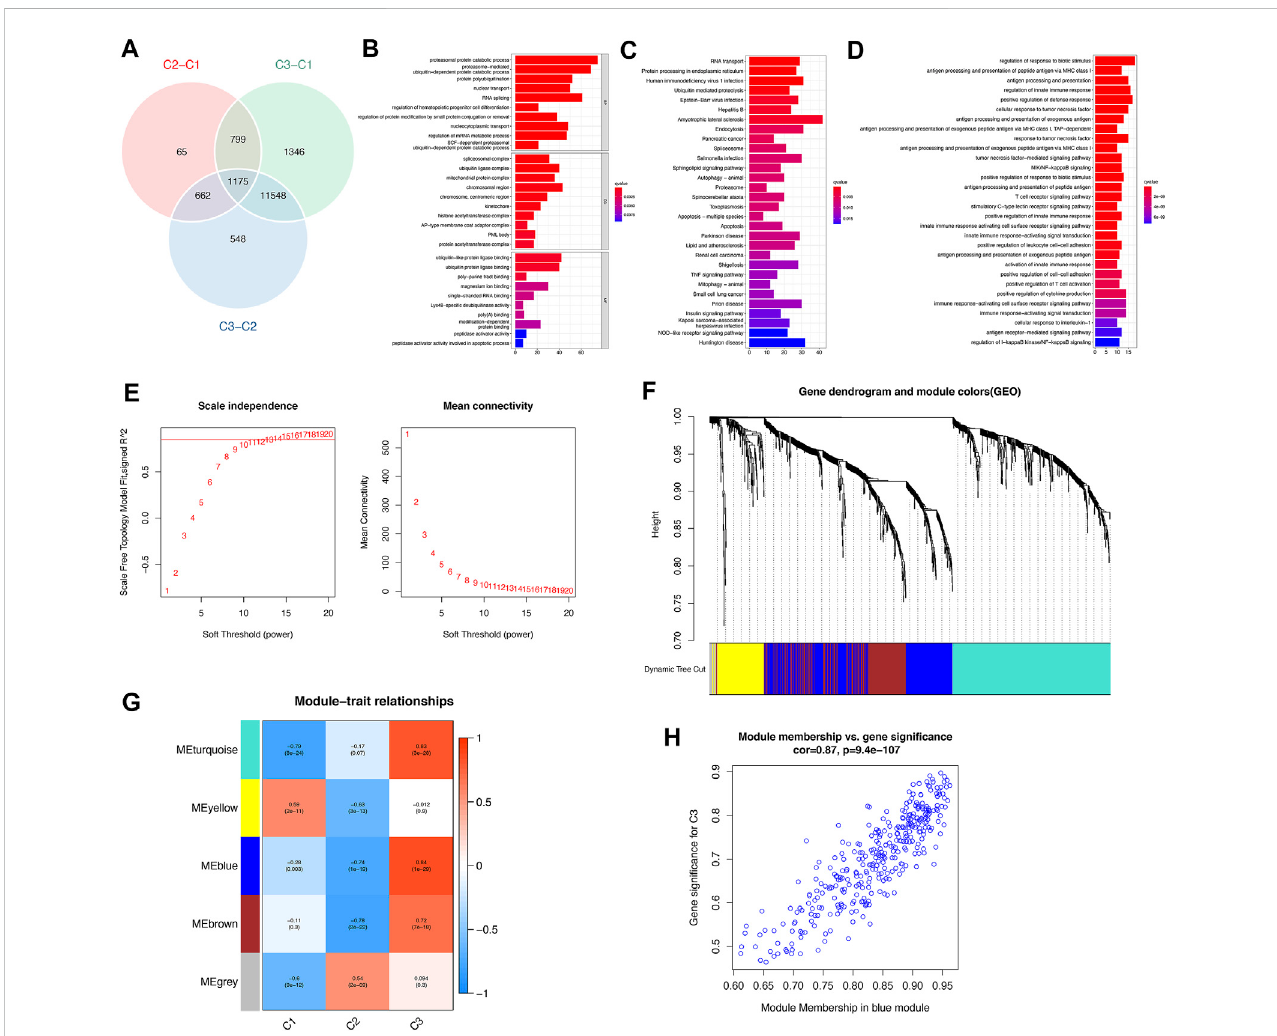
FIGURE 7 Identi fi cation and functional analysis of m 6 A phenotype-related genes in osteoarthritis. (A) Venn diagram of 1175 m 6 A phenotype-related genes. (B) GO enrichment analysis revealed the biological function characteristics of m 6 A phenotype-related genes. (C) KEGG enrichment analysis revealed the biological signaling pathways of m 6 A phenotype-related genes. (D) GO-BP enrichment results revealed the biological processes (BPs) of m 6 A modi fi cation-mediated immune genes. (E) Analysis of the scale-free topology model fi t index and the mean connectivity for various soft-thresholding powers. (F) Gene dendrogram obtained by average linkage hierarchical clustering. The color row underneath the dendrogram shows the module assignment determined by the dynamic tree cut, in which 5 modules were identi fi ed. (G) Heatmap of the correlation between characteristic gene modules and 3 distinct m 6 A subtypes: red indicates a positive correlation, and blue indicates a negative correlation. (H) The scatterplot of gene signi fi cance for m 6 A subtype C3 vs . module membership in the blue module. The gene signi fi cance and module membership exhibited highly signi fi cant correlations, implying that the hub genes of the blue module also tended to be highly correlated with subtype